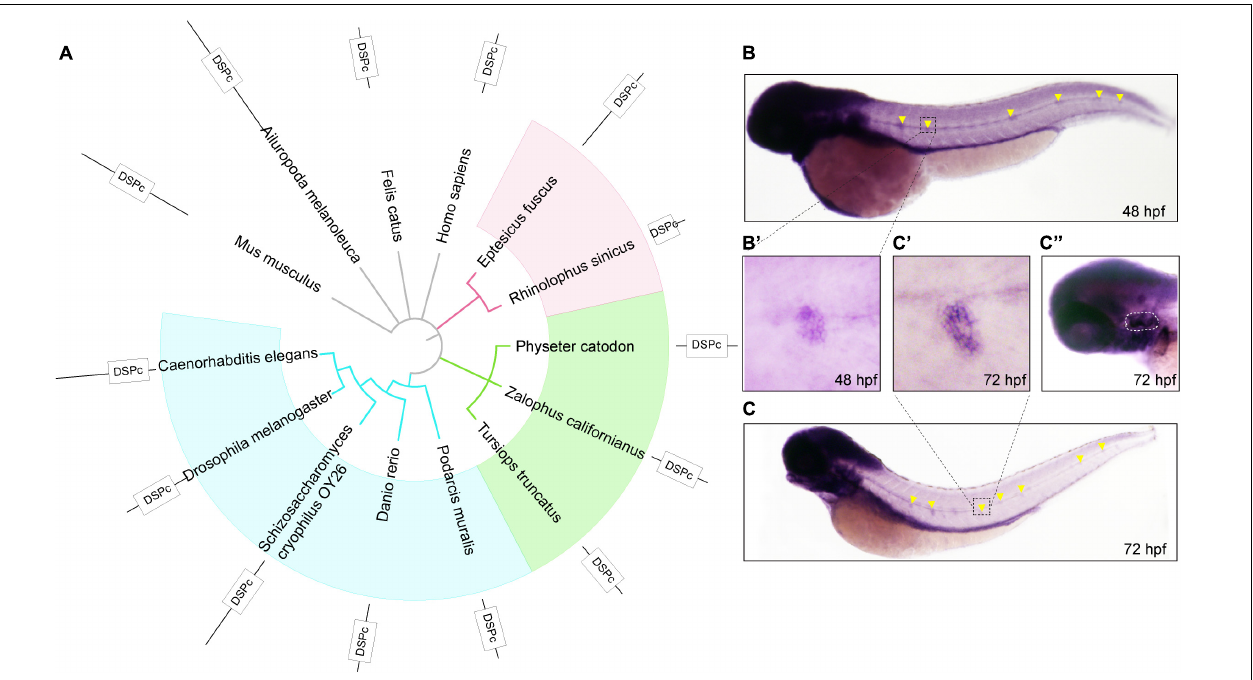
FIGURE 1 | The phylogenetic and expression analysis of zebrafish dusp14 . (A) A phylogenetic tree was generated using the PhyML software base on amino acid sequences. The pictures are mouse, giant panda, domestic cat, human, big brown bat, Chinese horseshoe bat, sperm whale, sea lion, bottlenose dolphins, lizards, zebrafish, Saccharomyces cerevisiae, and nematodes. (B,C) WISH with the dusp14 probe in wild-type zebrafish showed that the gene is expressed in the otic vesicle and lateral line at 48 hpf (B) and 72 hpf (C) . (B’,C’,C”) Are the detailed information with higher magnification of the (B,C) , respectively.